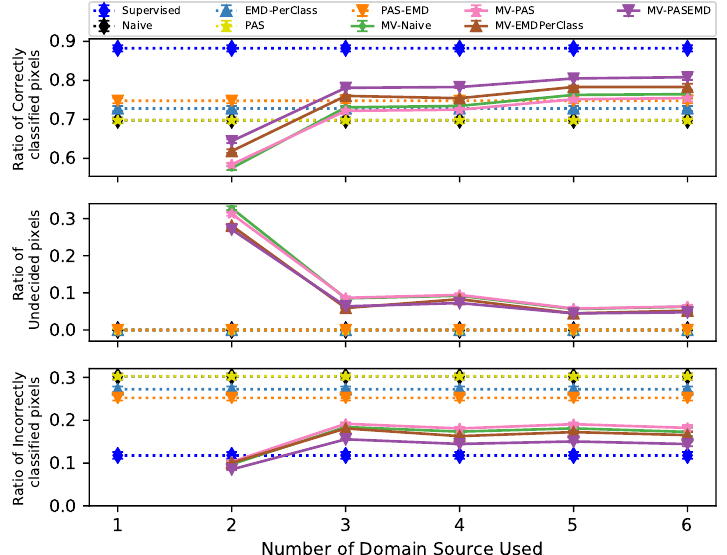
Figure 9. Pixel ratio between correctly classified ( top ), incorrectly classified ( bottom ) and undecided pixels ( middle ). The pixel ratio is displayed on the y-axis with different range and the number of source domains used on the x-axis. Horizontal lines represent reference cases: supervised in blue, naive in black, PAS in yellow, EMD-PerClass in light blue and PAS-EMD in orange. Other curves represent the majority voting: MV-Naive in green, MV-PAS in pink, MV-EMD-PerClass in brown, MV-PAS-EMD in purple.